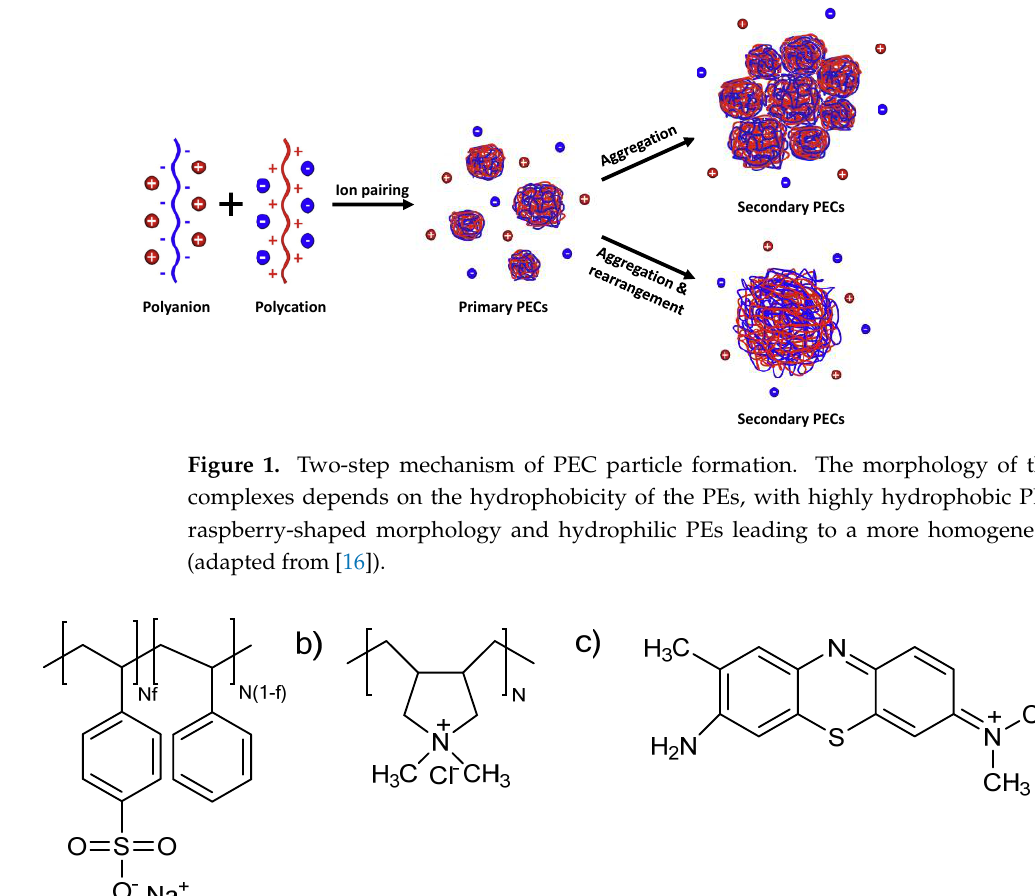
Figure 2. Molecular structure of ( a ) P(St-co-SSNa), ( b ) PDADMAC, ( c ) o -toluidine blue. N is the degree of polymerization and f represents the chemical fraction of sulfonated units in P(St-co-SSNa).